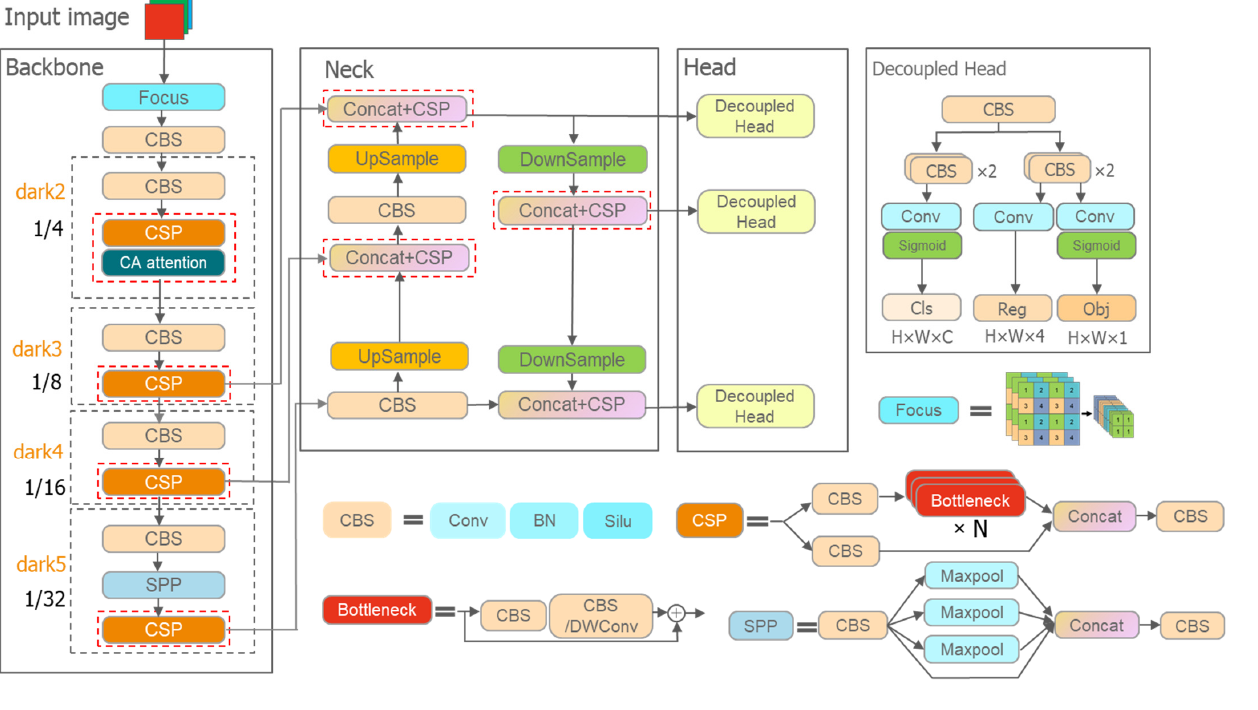
Figure 6. YOLOX network structure. The red dotted boxes are the alternative locations for adding the attention module. The Conv, BN, and Silu denote Convolution, Batch Normalization, and SILU, respectively. The Concat and Maxpool denote Concatenation and Maximum pooling operations. The DWConv is a variant of the Convolution operation. The Cls, Reg, and Obj represent the classification, the regression parameters of each feature point, and the detected target’s confidence score information from the input image. The prediction box can be obtained by adjusting the regression parameters. The confidence score represents the probability that each feature point prediction box contains an object. The H, W, and X indicate the feature maps’ width, height, and number of channels.